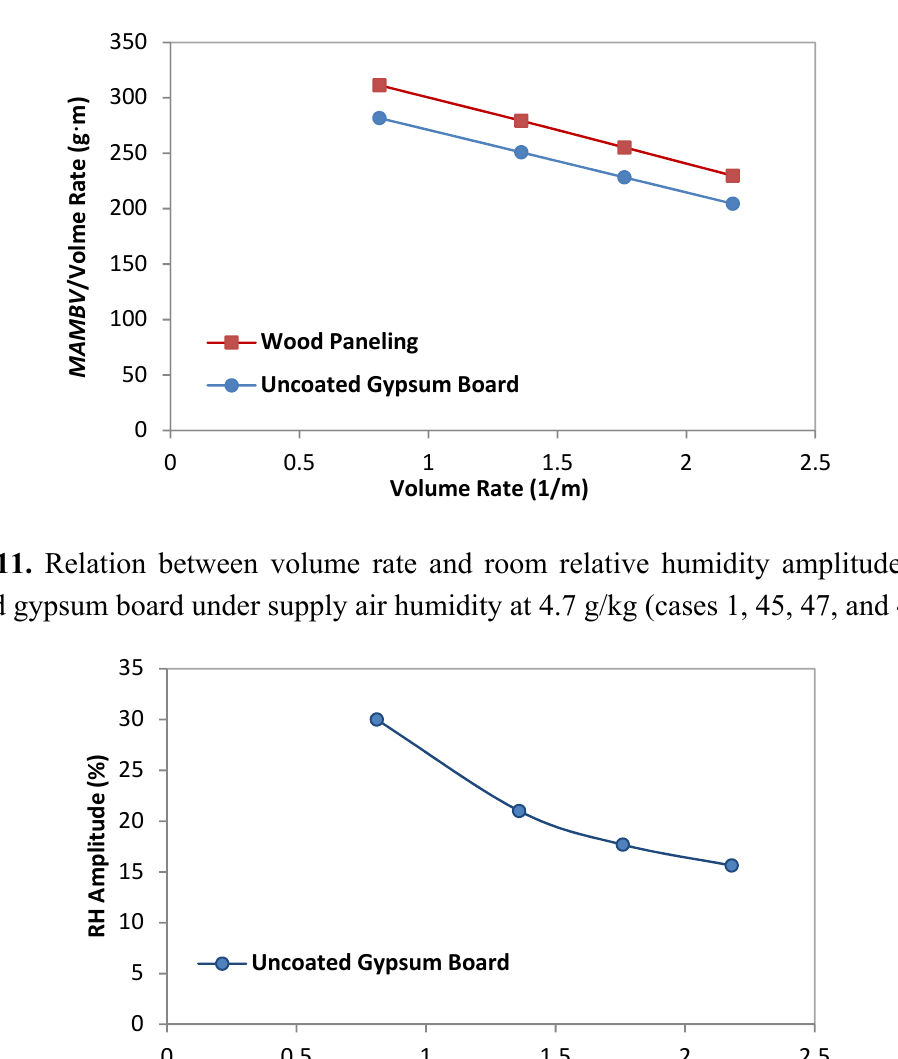
Figure 10. Relation between the volume rate and the MAMBV/volume rate for both wood paneling and uncoated gypsum board for cases 1, 11, 45–50.